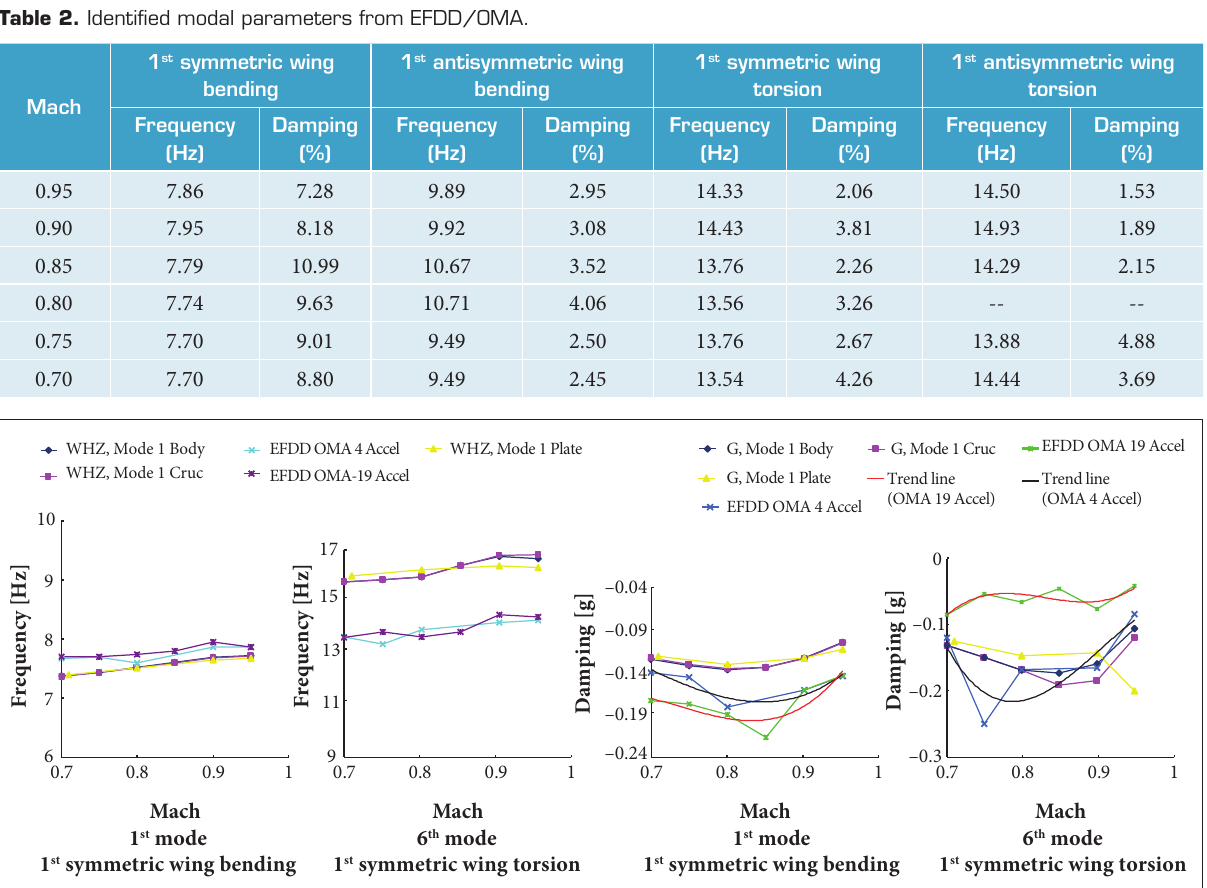
Figure 11. Comparison between measured and computed aeroelastic frequencies and damping for two symmetric mode